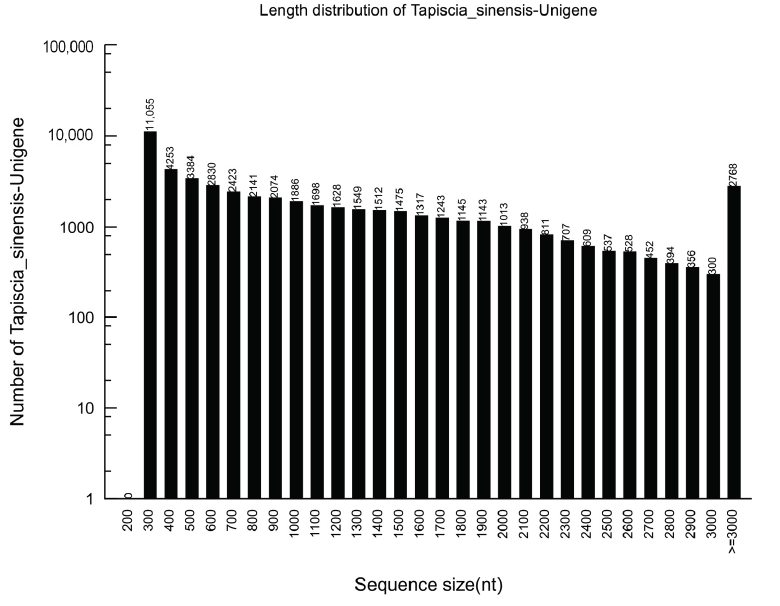
Figure 1. Length distributions of the unigenes in the assembled